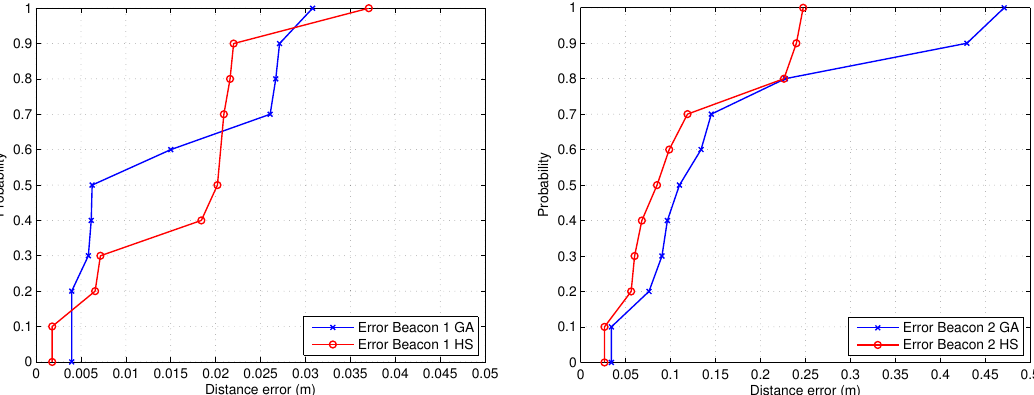
Figure 12. Experimental results for the estimations of beacon #1 (left) and beacon #2 (right). Note that the X-Y scales are completely different in these two subplots.